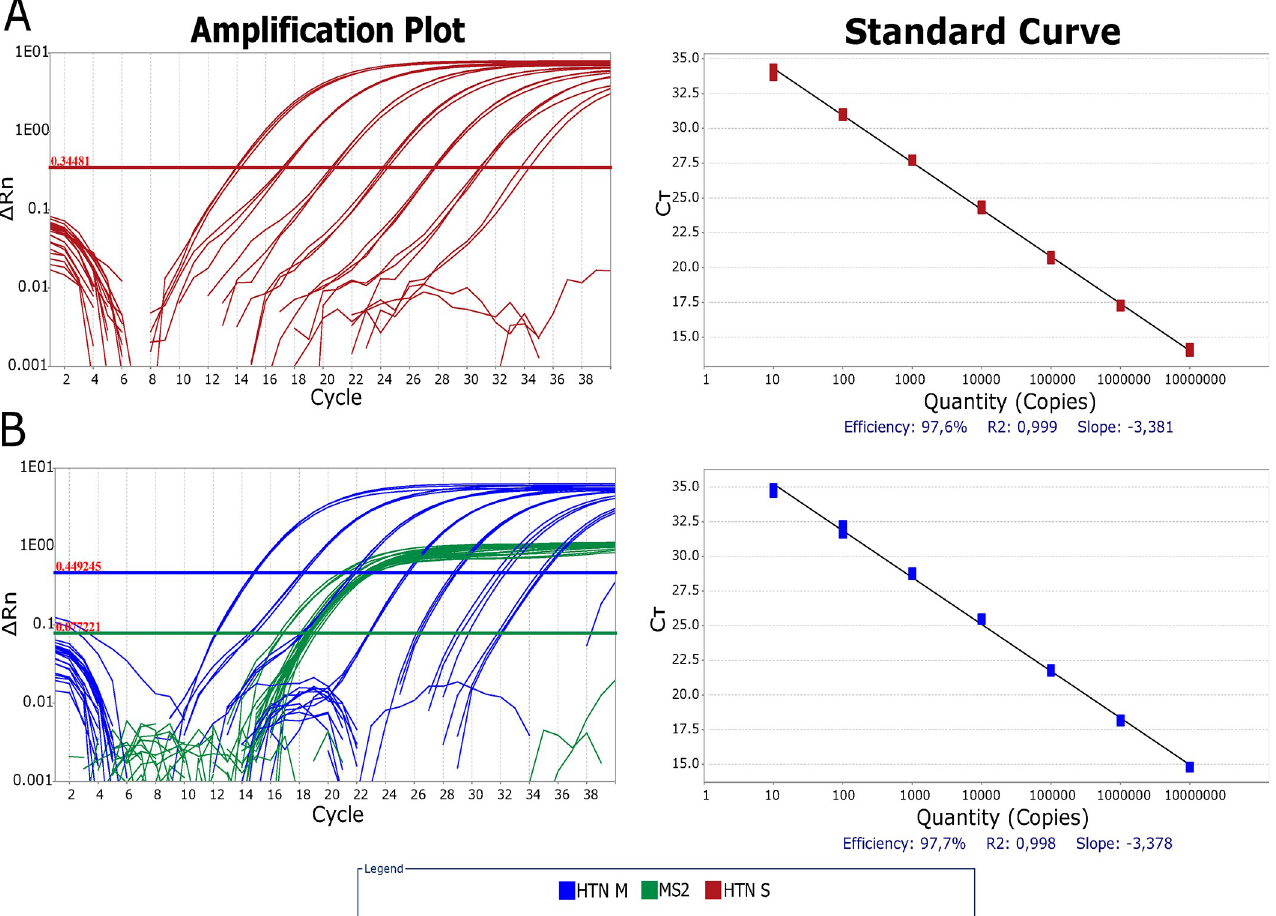
Fig 1. Comparison between amplification efficiencies of hantavirus RT-qPCR in singleplex and multiplex with MS2 EIC formats. Amplification plot and Standard Curve for each assay format are depicted. Threshold was fixed where the amplification efficiency was higher, inside the exponential phase of each amplification plot in logarithmic scale, with 0.3481 Δ Rn in singleplex (A) and 0.4492 Δ Rn in multiplex (B). Ct variation between singleplex and multiplex was within 1 Ct. Standard curves were constructed with seven 1:10 dilutions ranging from 10 7 copies to 10 1 copies of in vitro RNA. Amplification efficiency was 97.6% for singleplex (R 2 :0.999) (A) and 97.7% for multiplex (R 2 :0.998) (B). Ct: Cycle threshold, HTN M: hantavirus RT-qPCR multiplex format, HTN S: hantavirus RT-qPCR singleplex format.